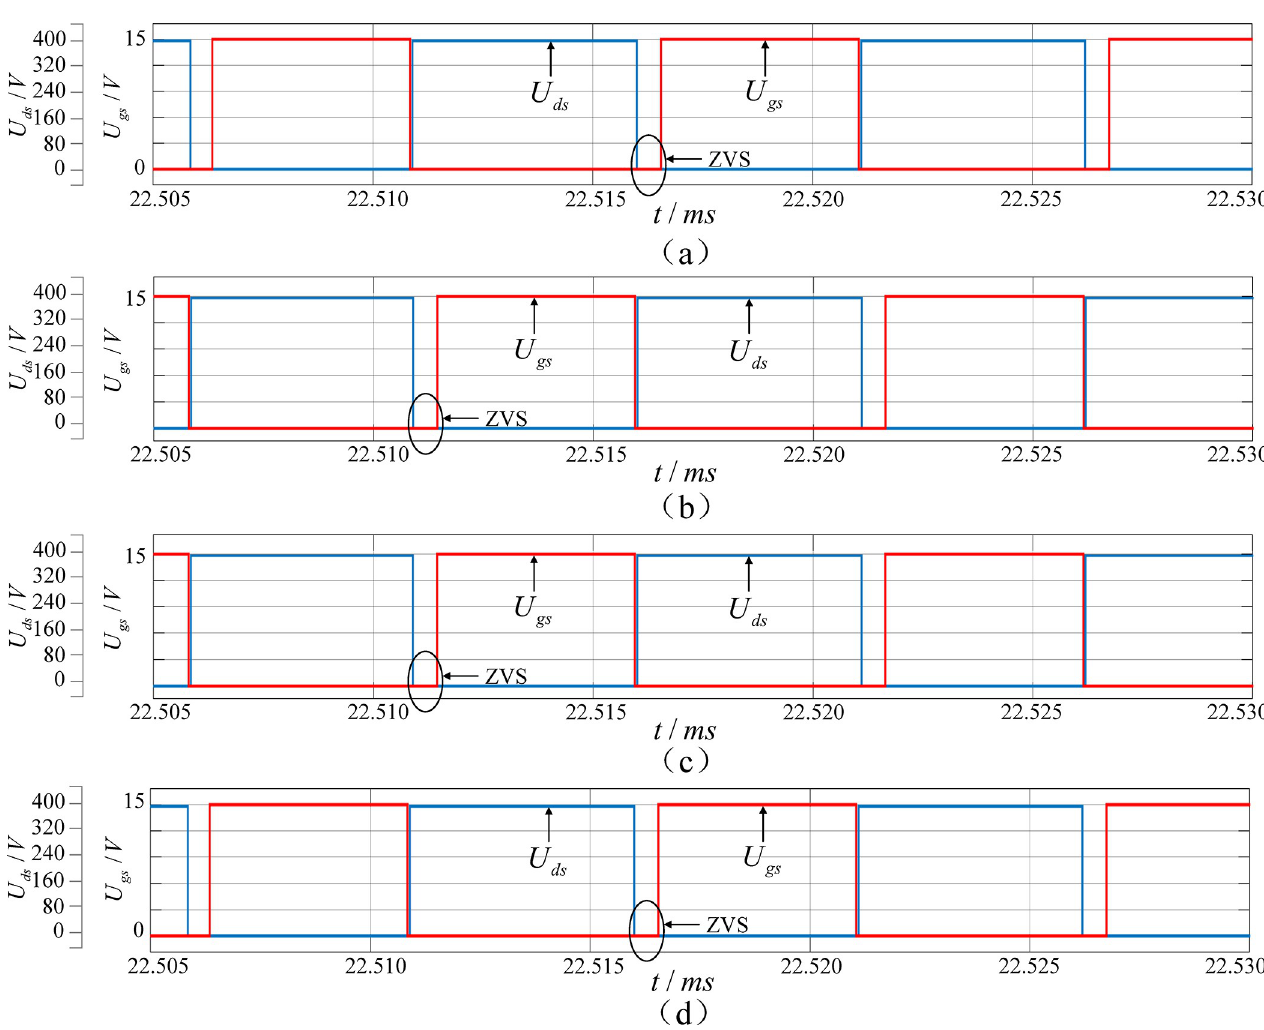
Fig 19. Operating waveforms of power switches Q 1 (a), Q 2 (b), Q 3 (c) and Q 4 (d) on the primary side.